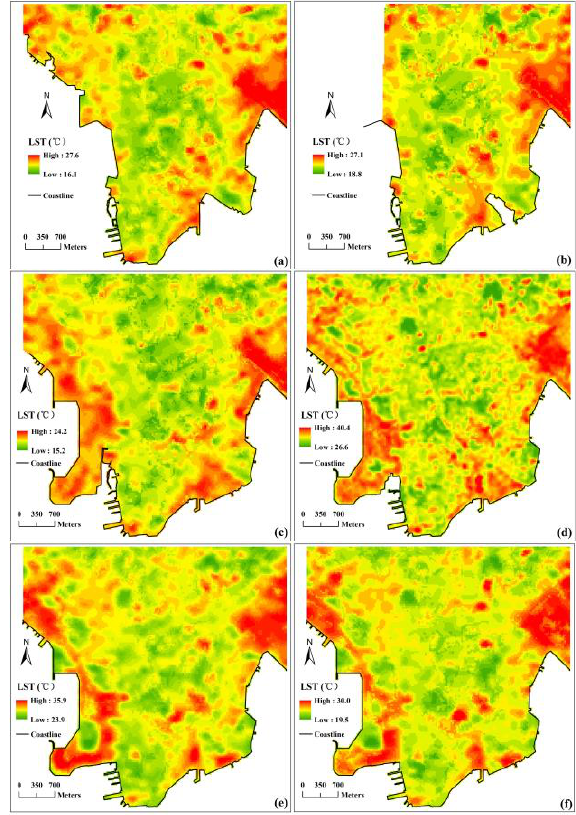
Figure 2. Spatial pattern of LST in the Kowloon Peninsula at 30 (e): 2005; (f): 2009